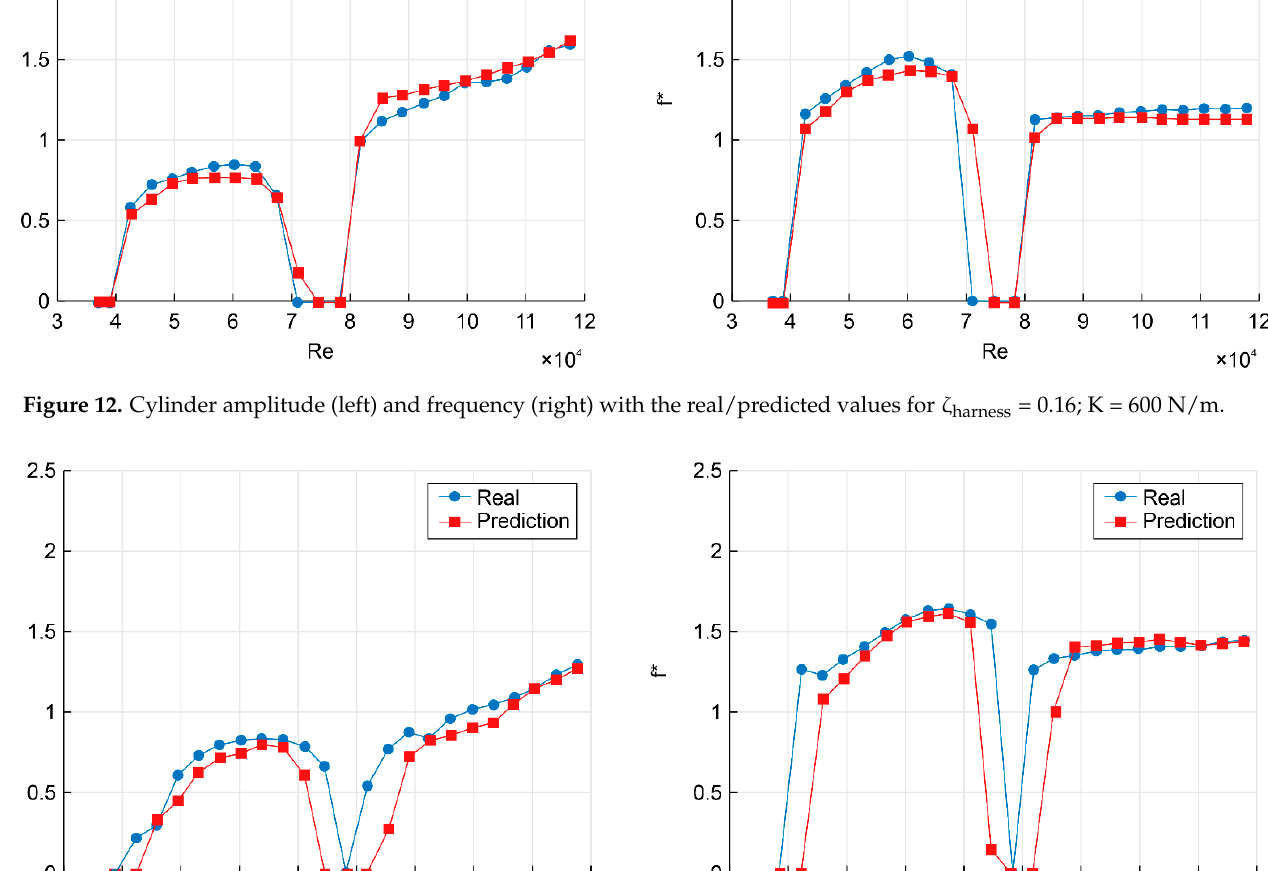
harness = 0.16; K = 1000